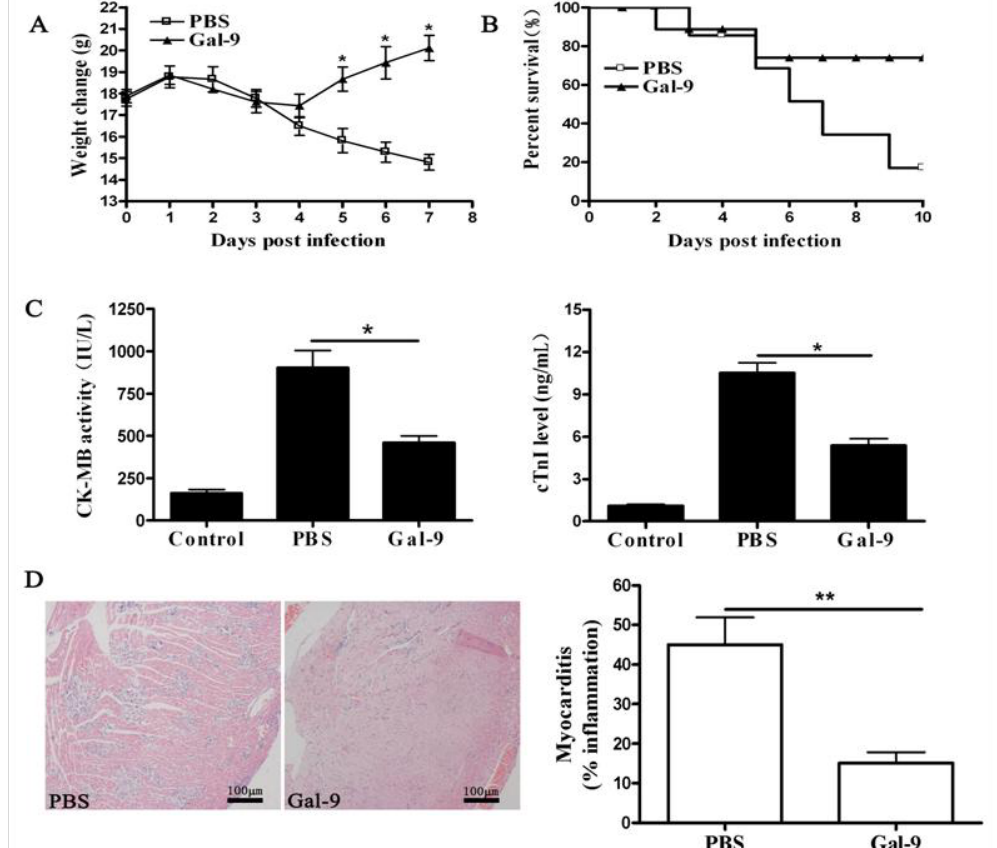
inflammation. BALB/c male mice were infected with CVB3 on day 0 and then received recombinant galectin-9 ( n = 8) or PBS ( n = 8) IP daily from day 3 to day 7. The